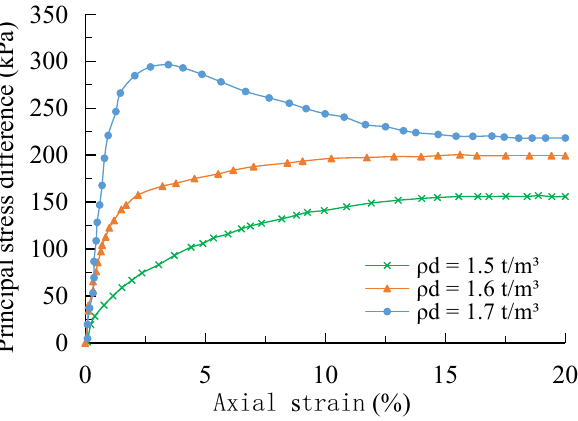
Figure 12. Stress–strain curve under various dry densities (Saturation = 70%, σ − µ a = 150 kPa).